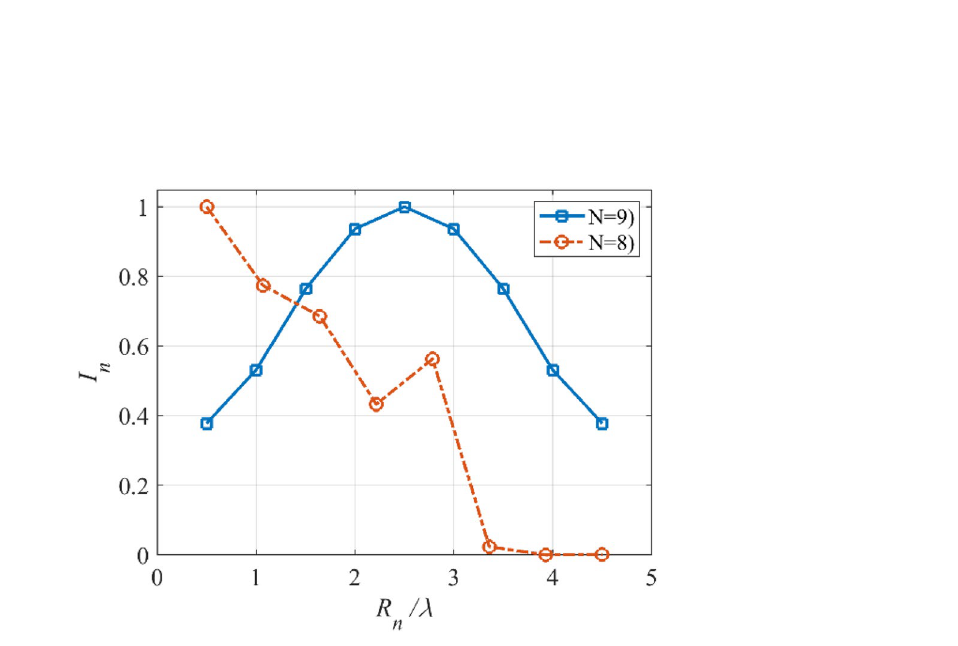
Figure 17. The obtained I n ’s of the fifth